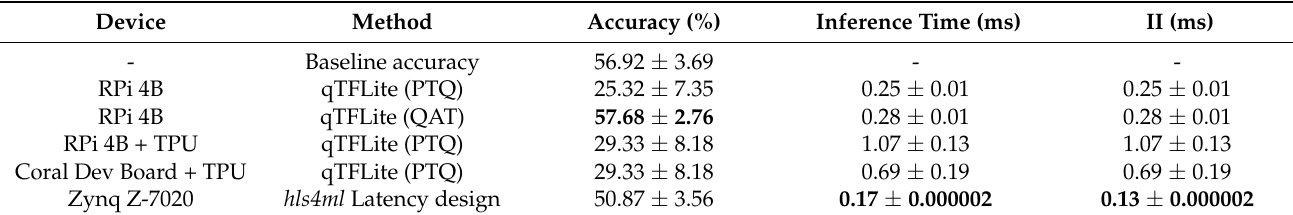
Table 11. CNN1D: Zynq Z-7020 vs. other embedded devices for the UrbanSound